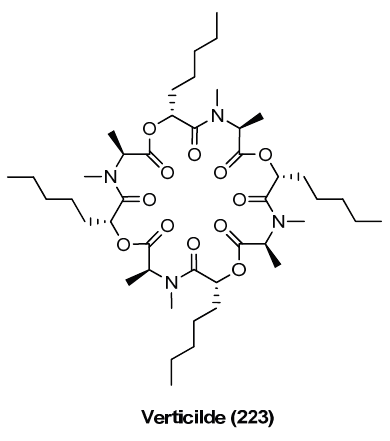
Figure 24. Structure of verticilide ( 223 ).